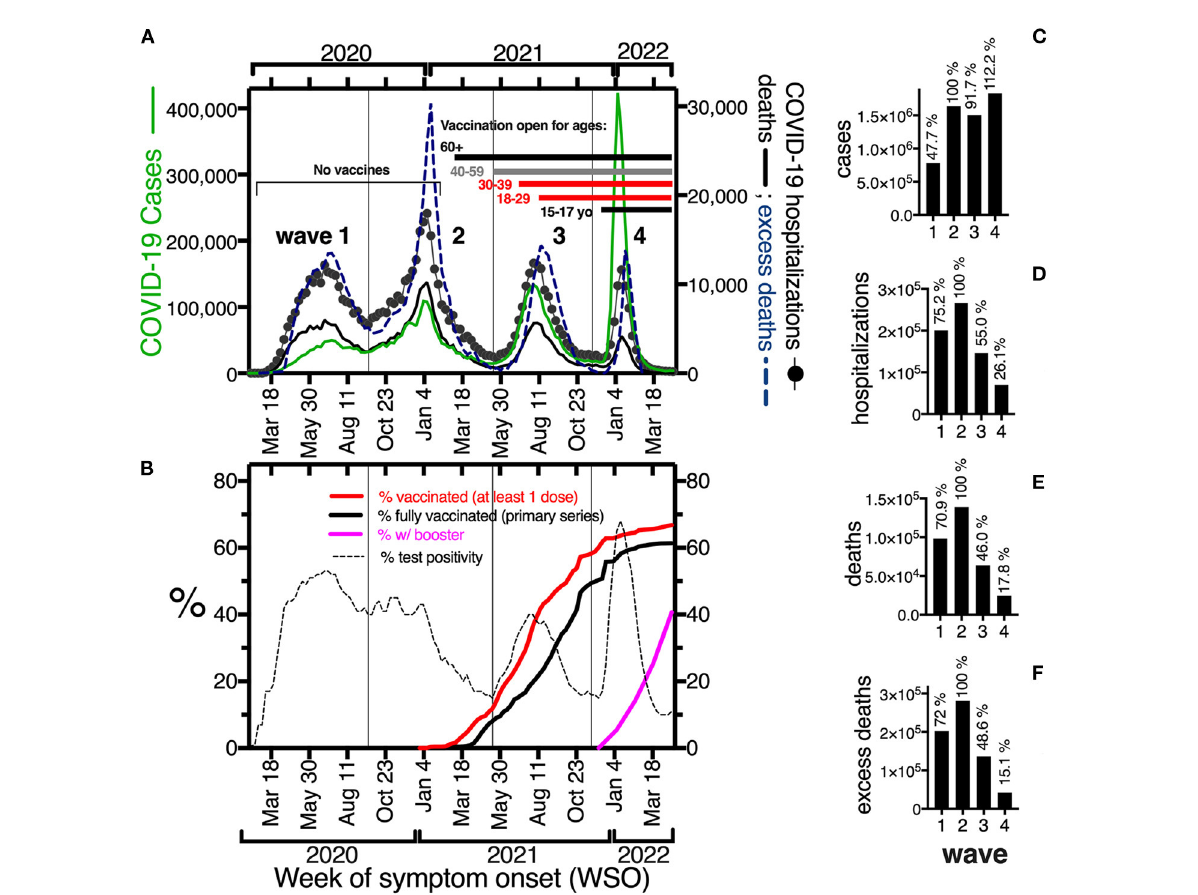
FIGURE1 (A) Epidemic curve of COVID-19 cases (green line, left y-axis), COVID-19 hospitalizations (line with black circles) and deaths (bold black line); and all cause-excess deaths (blue discontinuous line) in the right y-axis, during the first 27 months of epidemic (Feb 2020–April 2022) in Mexico, per week of symptom onset, including all ages. (B) Percent test positivity for SARS-CoV-2 (discontinuous line), and percent population vaccinated with at least one dose (red line), a complete primary series (bold black line) or a complete primary series plus a booster (pink line), in the same period as in (A) . Vertical lines separate waves. (C–F) Accumulated COVID-19 cases, hospitalizations, deaths and all cause-excess deaths per wave. The percentages on top of bars were calculated using the second wave as